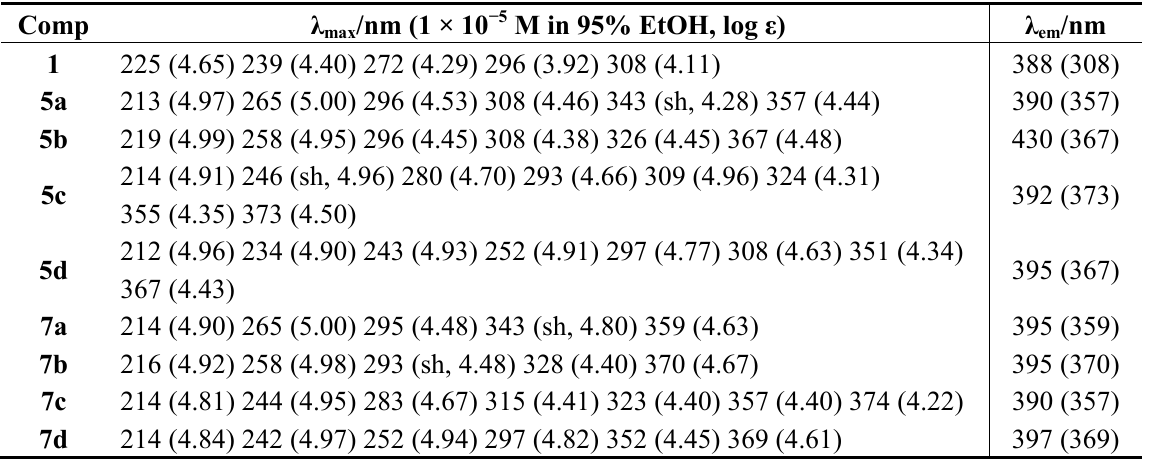
Table 2. UV absorption and fluorescence spectral data of spirobifluorene, 5 and 7 .